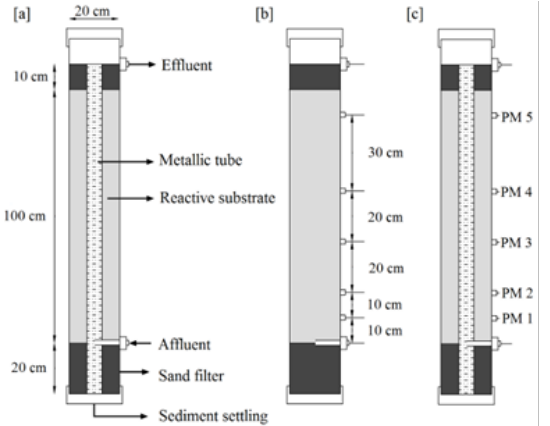
Figure 1. design of passive reactor prototypes: ( a ) sulfidogenic diffusion exchange systems (SDES) replicas without sampling ports and with metal screens (reactors A and B); ( b ) The dispersed alkaline system (DAS) with sampling ports and without a metal screen (reactor C); ( c ) The alkaline diffusive exchange system (ADES) with sampling ports and a metal screen (reactor D).